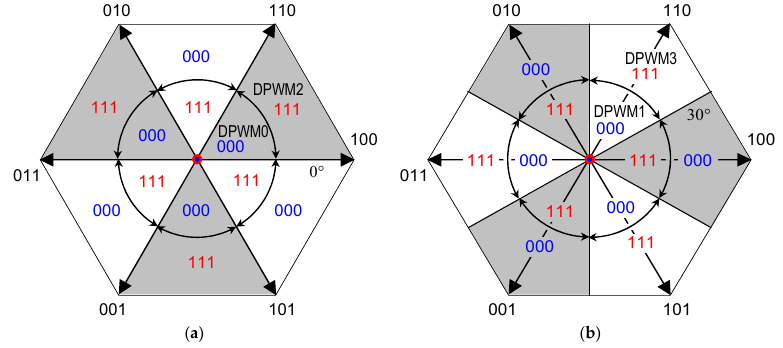
Figure 2. Distribution of zero switching states in balanced discontinuous pulse ‐ width modulations (DPWMs): ( a ) inner: DPWM0 and outer: DPWM2; and ( b ) inner: DPWM1 and outer: DPWM3.